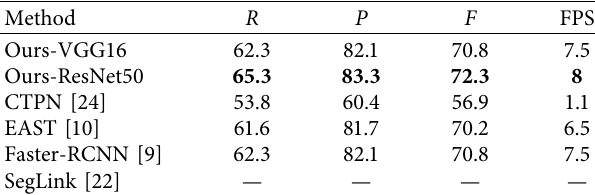
Table 2: Results on the MSRA-TD500 dataset. Method R P F